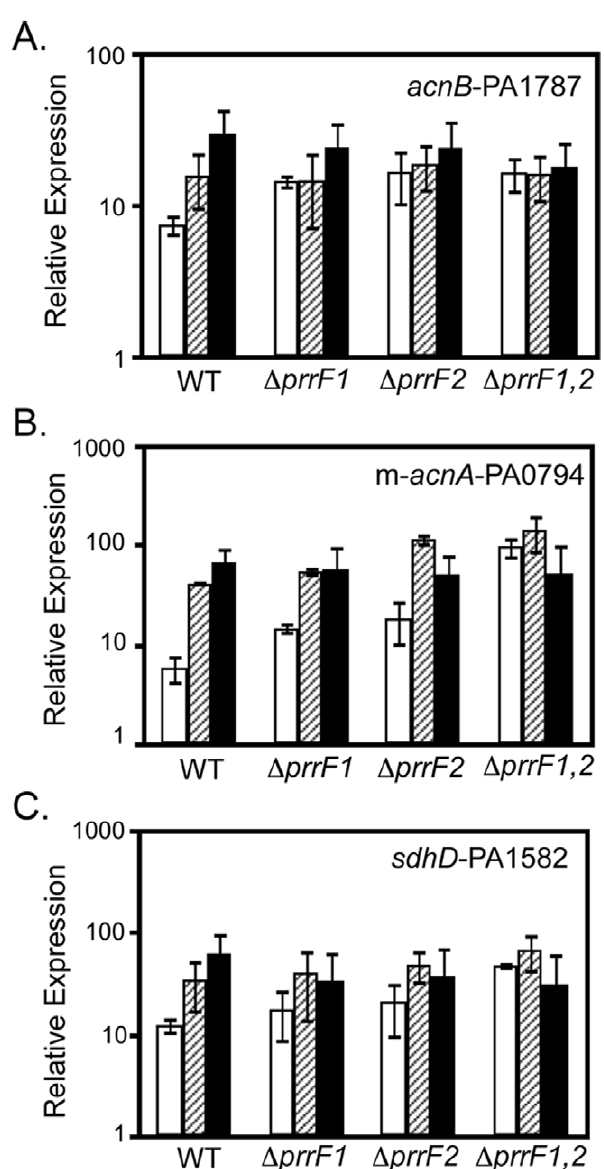
Figure 5. Effect of heme on the expression of PrrF-regulated genes. RNA isolated from the indicated strains, grown for 18 hours in CM9 + 1% glycerol with no added iron (white bars), 40 m M hemin (hatched bars), or 100 m g/ml FeCl 3 (black bars) was used for qRT-PCR as described in the Materials and Methods. Error bars represent the standard deviation of expression of (A) acnB -PA1787, (B) m- acnA - PA0794, and (C) sdhD -PA1582 from at least three independent